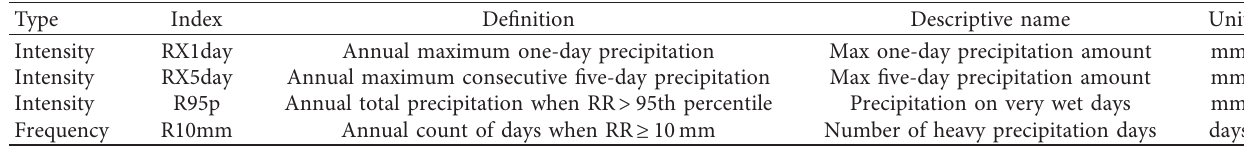
Table 2: Definitions of extreme precipitation indices.